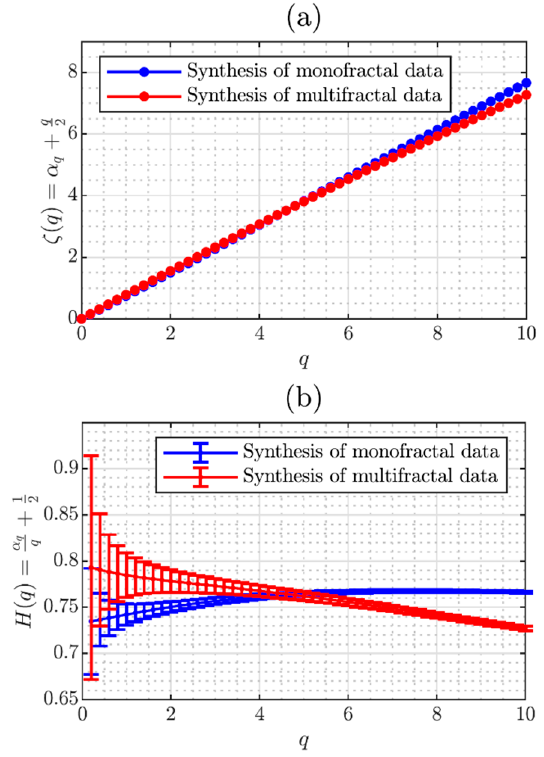
Figure 14. ( a ) MD for monofractal and multifractal traces. ( b ) LMD for single-phase and multifractal traces.